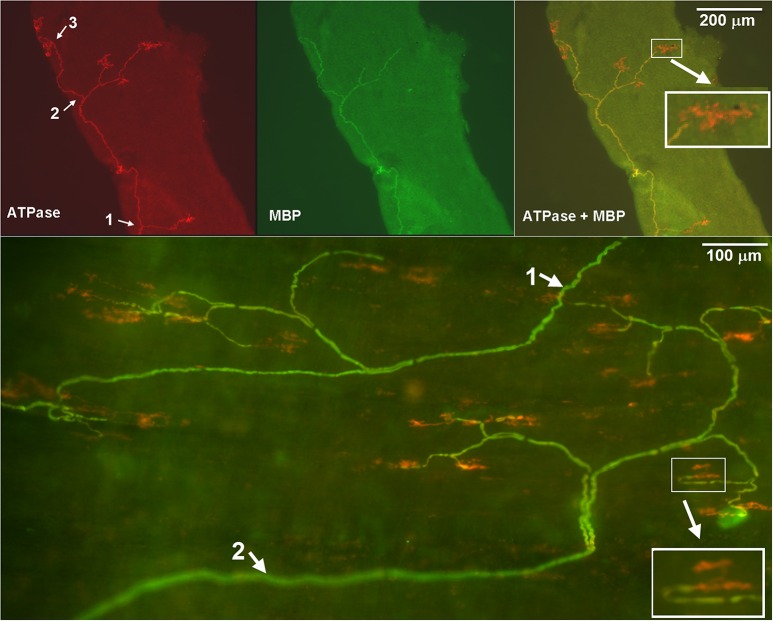
A double staining approach to illustrate SAR sensory structures identified in rabbit airways. Na+/K+-ATPase stains all structures in the sensory unit (red), whereas myelin basic protein (MBP) stains the myelin sheath (green) and shows yellow (co-staining) in the composite figure (top-right and bottom parts). Clearly, the axon demyelinated before it reaches the end formation. Thus, the receptor can be identified (pure red portions without co-stain with MBP). Top (small airway, 300 μm in diameter): The parent axon of the sensory structure is running from the bottom up. It gives off three branches, indicated by white arrows 1, 2, and 3 in the top-left panel. Its first branch is at the bottom of the figure, the second one in the middle part, and the third one at the upper part. Six receptors can be identified in this microscopic view (1 in the first branch, 3 in the second and 2 in the third). They are showing red on double stain. Bottom (trachea): two parent axons (one starts at up-right and one at low left, indicated by white arrows 1 and 2) can be identified. The up-right sensory structure (1) has 9 receptors and the low-left one (2) has 13 receptors. Insets are enlarged to illustrate the sensory receptors.